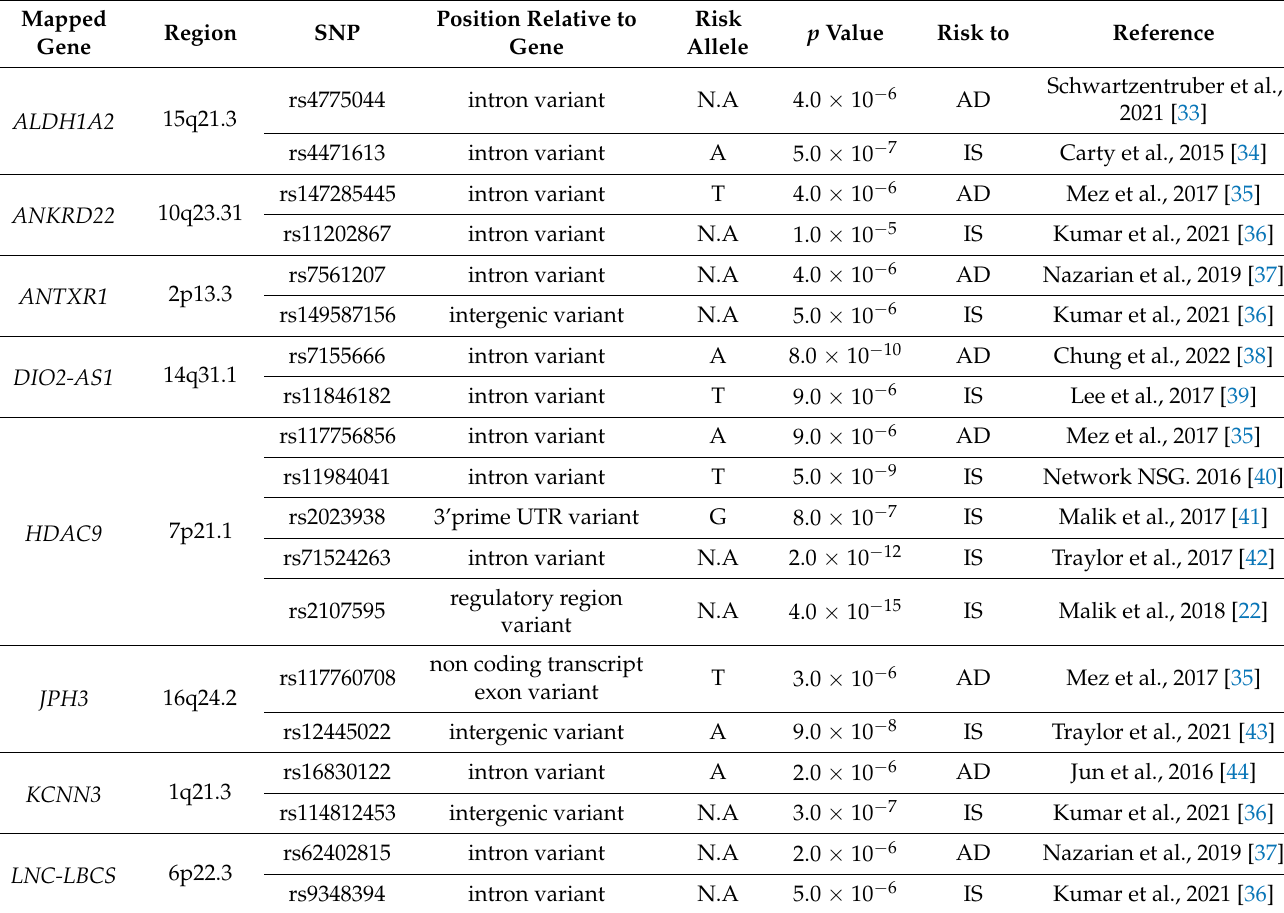
Table 1. Common susceptibility genes and their related SNPs in AD and